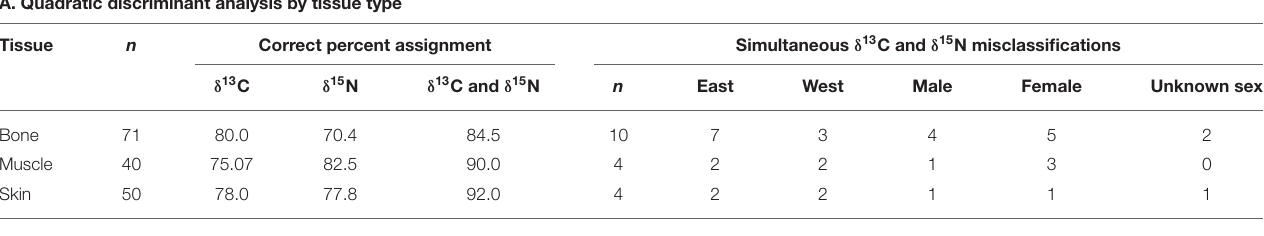
B. Specimens correctly assigned across tissue